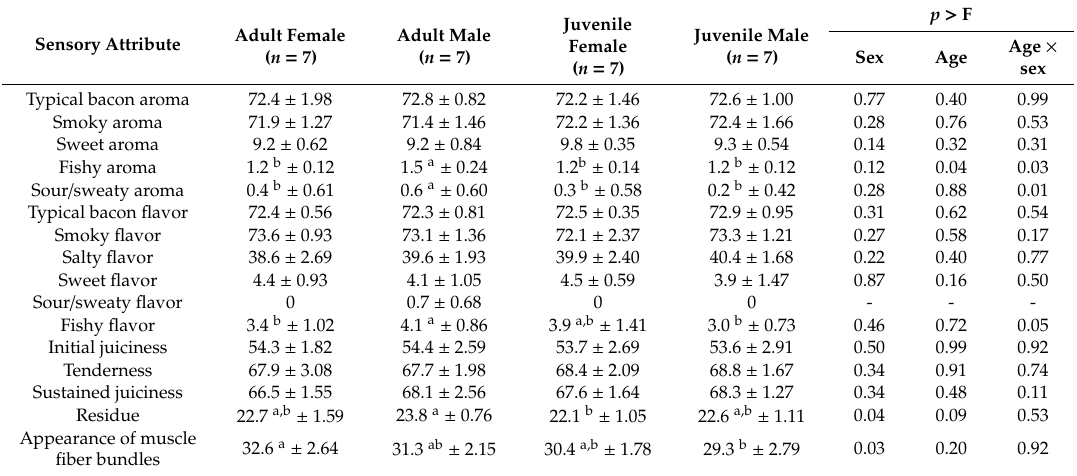
Table 5. The mean values ( ± SD) of the sensory attributes of cooked warthog back bacon according to sex and age.